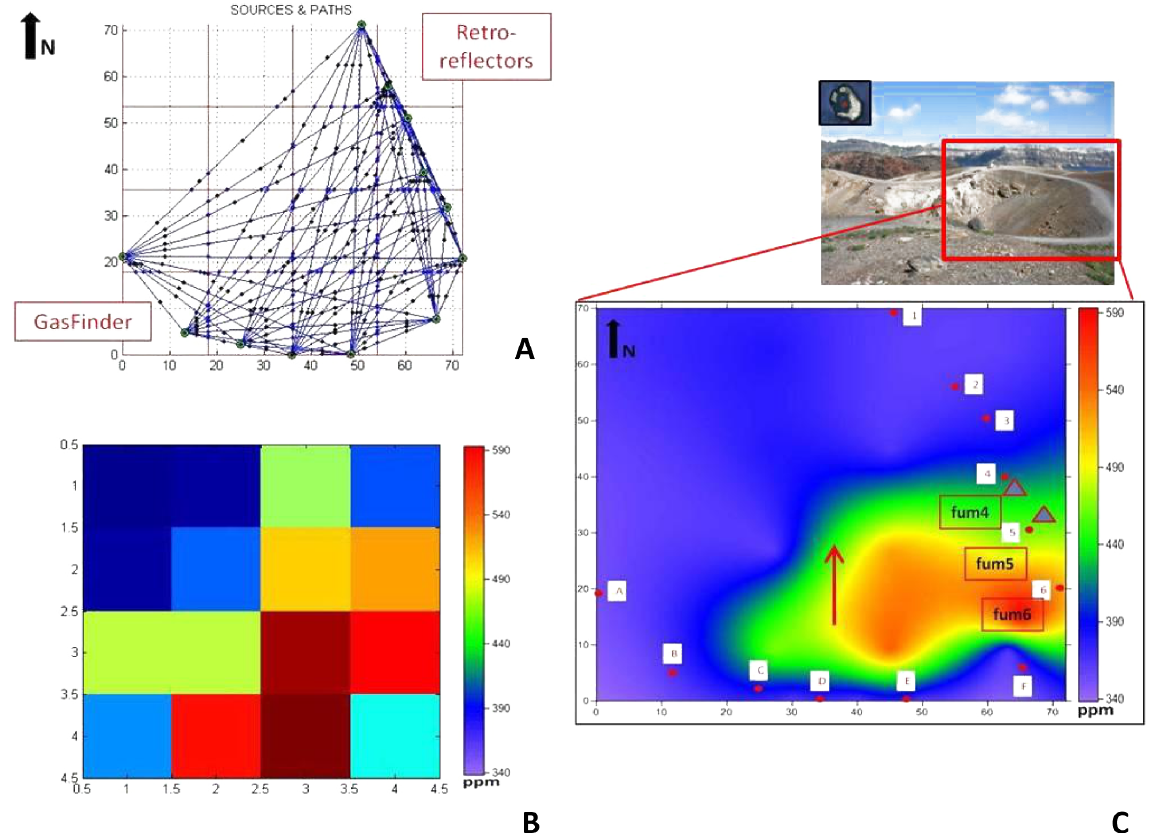
Figure 2. Output of the tomographic algorithm, and example for the Nea Kameni campaign, 9 April 2013 is shown. (a) Geometric recon- struction of the field experimental set-up and (b) tomographic matrix. The script uses a data inversion procedure to assign an averaged CO 2 mixing ratio (in ppm) to each cell of the matrix. (c) CO 2 mixing ratios (ppm) contour map. GasFinder and retro-reflectors positions are shown with letters and numbers, respectively. “Fum4”, “Fum5” and “Fum6” are the positions of main degassing vents; blue triangles are the permanent INGV-PA stations; the red arrow depicts the principal direction of plume